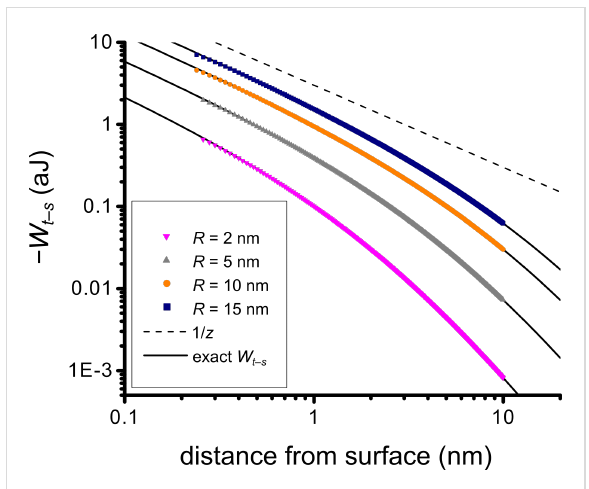
Figure 4: Hamaker force for flat surfaces: Relationship between tip potential and distance from the surface. Here the distance is taken relative to the surface position (distance from surface = z ( x ) − z s ( x )). The dashed line is a reference for the 1/ z dependence expected from the Hamaker force law for the interaction between a flat surface and a sphere. The numerical results show excellent agreement with the exact potential (Equation